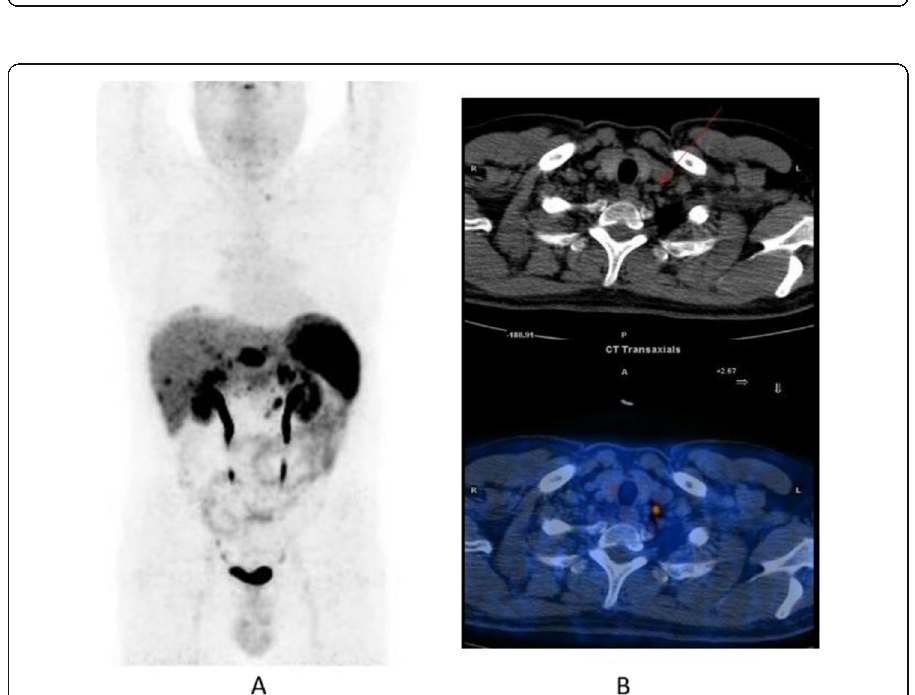
Fig. 55 68 Ga-DOTA peptide, staging NET of the pancreas, sensitivity. Clinical history : 60 y.o. man. Incidental finding of a NET of the pancreas grade 2 (Ki67 5%). PET/CT findings : multiple areas of increased tracer uptake in the pancreas, liver, and abdominal lymph nodes ( a MIP). Note the uptake in a left supraclavicular lymph node 5 mm in size ( b CT and fused